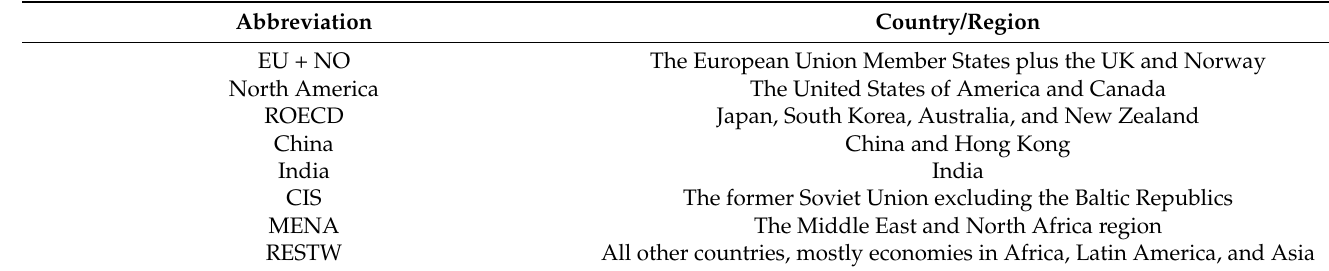
Table 1. PROMETHEUS model